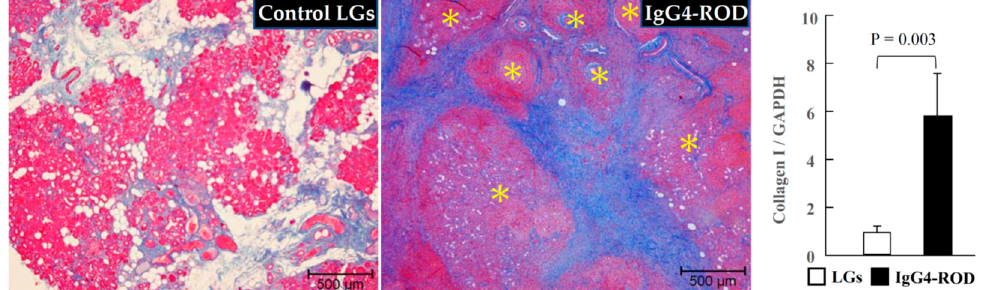
Figure 2. Representative images of Azan Mallory staining and collagen-I expressions of the LGs obtained from the patients with IgG4-ROD and from the patients diagnosed with severe canalicular obstruction yet with no IgG4-ROD. In the LGs of the normal control subjects, the lobes were surrounded by light-blue fibrotic interstitial tissue, while a dark-blue staining in the lymphocytic hyperplasia focus surrounding tissues was observed in the LGs from the patients with IgG4-ROD. Yellow asterisks indicate the area of lymphocytic hyperplasia. Bar graphs show the gene expressions of collagen-I in the LGs of the two groups.